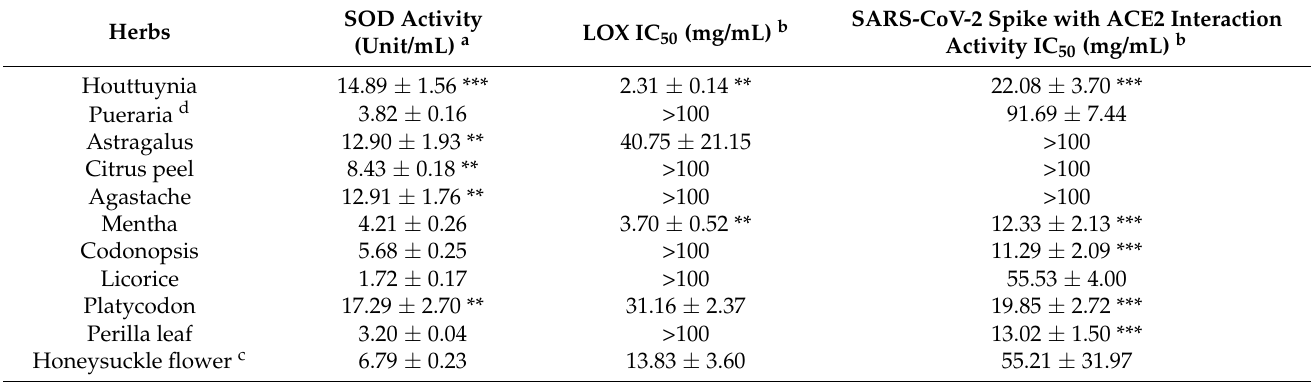
Table 4. Effect of herbal aqueous extract on SOD, LOX, and SARS-CoV-2 spike with ACE2